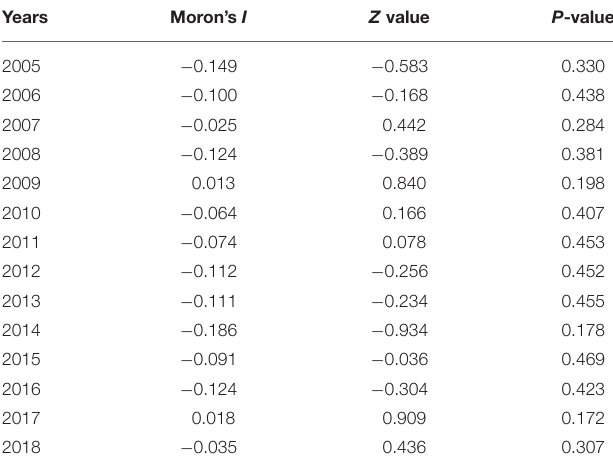
TABLE 3 | Global autocorrelation of the incidence of mumps in Wuhan City from 2005 to